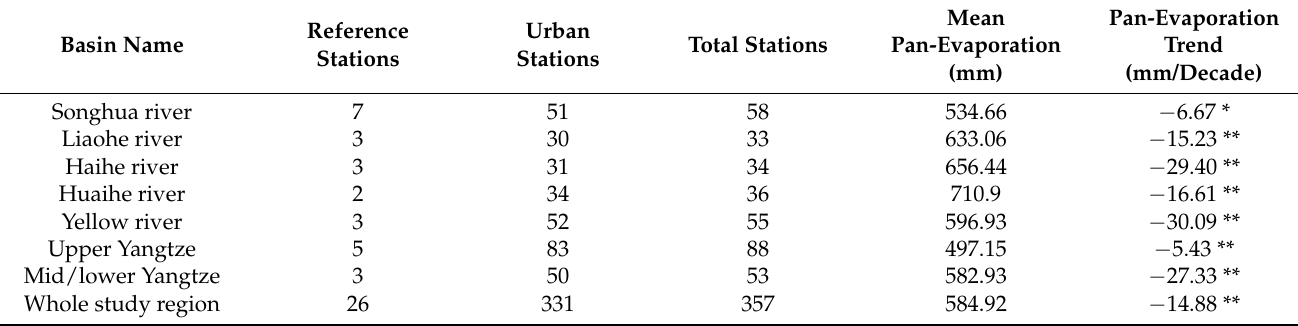
Table 1. Numbers of reference, urban and total stations, and mean and trend of warm-season pan-evaporation during 1961–2017, in each river